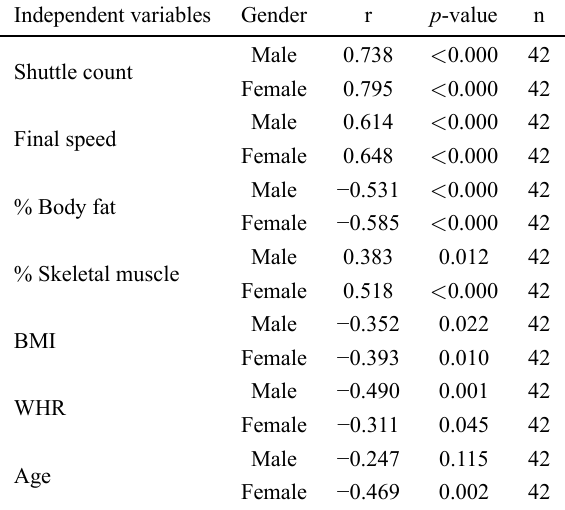
Table 4. Correlation of each independent variable